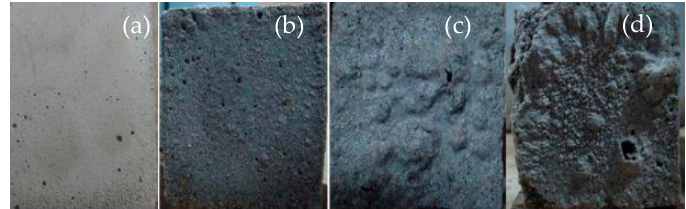
Figure 8. Apparent morphology of the mortar prism under different corrosion cycles. ( a ) 0, ( b ) 100 cycles, ( c ) 200 cycles, and ( d ) 300 cycles.